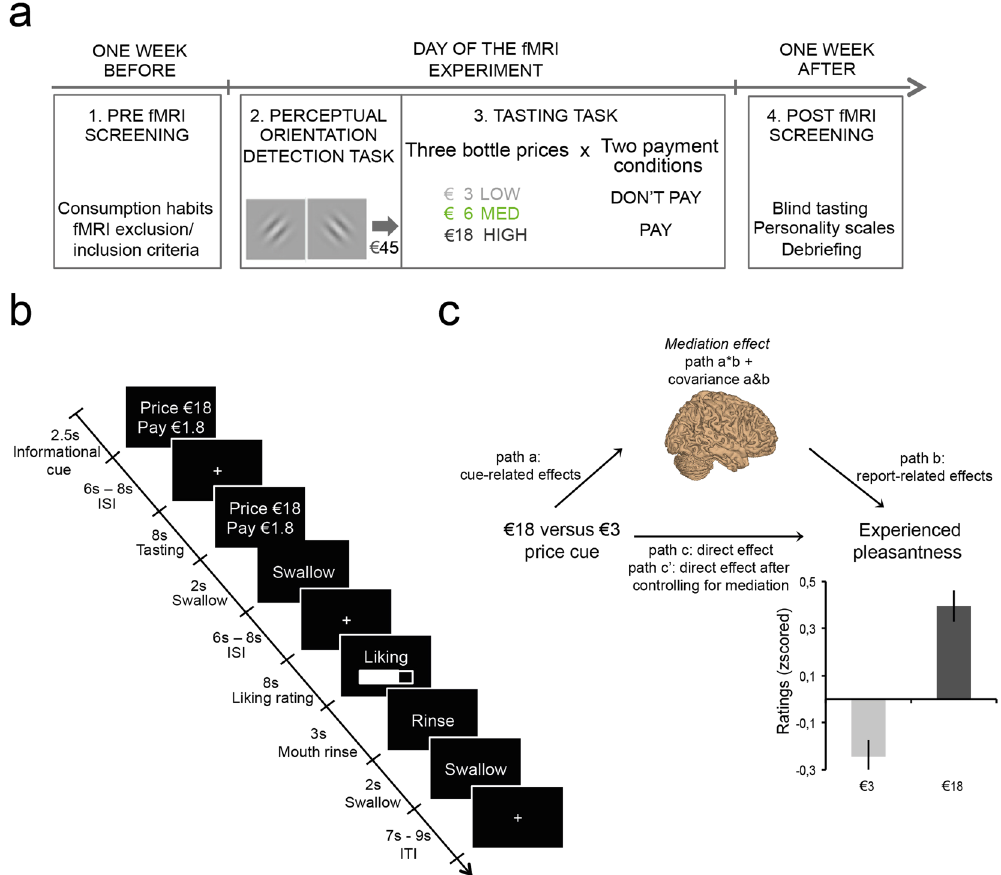
Figure 1. Experimental procedure, wine tasting task and results in N = 30 participants. ( a ) Experimental procedure: The experiment consisted of three events spread over two weeks. ( b ) Wine tasting task: Screenshots depict events within one trial with durations in seconds. Each trial started with the display of the price and payment condition. Following a jittered interstimulus interval (ISI) with a fixation cross on the screen, 1.25 ml of wine was tasted via a tube and subsequently swallowed. Participants rated on a visual analogous scale their experienced pleasantness. They then rinsed their mouth with a water-like neutral liquid. Trials were separated by a jittered inter-trial interval (ITI) during which a fixation cross was displayed on the screen. ( c ) Mediation framework and behavioral results from N = 30 participants: Multilevel whole-brain mediation involved high and low price cue trials (€18, €3) as predictor variables, trial-by-trial beta images of brain activation at time of wine tasting as a mediator variable, and experienced taste pleasantness ratings as a dependent outcome variable depicted in the bar graphs. Error bars correspond to the standard error of the mean (SEM). Note that the effect of price cue was linear across the three price conditions, replicating prior work 6 . There was no effect of payment condition (see SI Figs S1–S3), which was fit into the model as a covariate of non-interest alongside wine